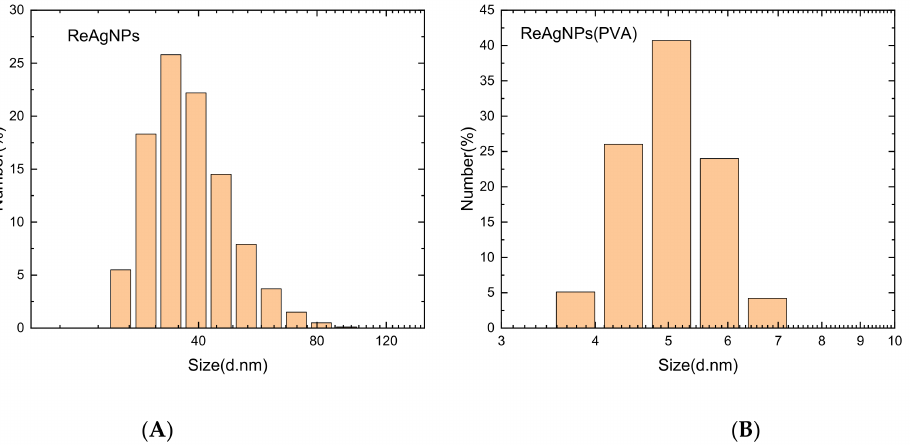
Figure 9. DLS analysis results in the form of particle size histograms according to distribution for ( A ) a solution of rhenium–silver nanoparticles synthesized without a stabilizer (PVA). ( B ) A solution of rhenium–silver nanoparticles synthesized in the presence of a stabilizer. Both rhenium and silver concentrations were 1 × 10 − 4 mol/dm 3